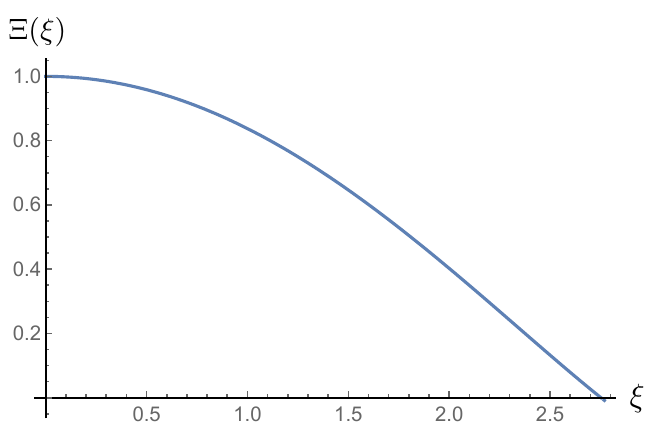
Figure 1: Numerical solution of Lane-Emden equation